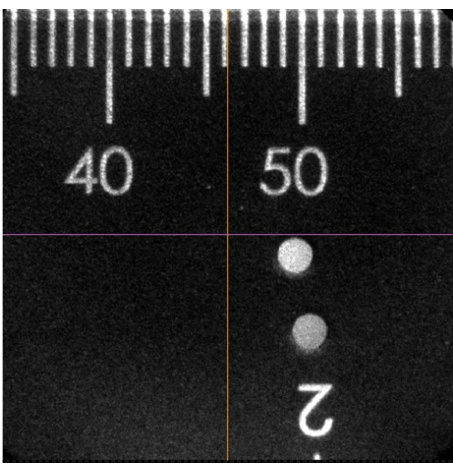
Figure 2. The image of a Thorlabs steel ruler on the ICCD active area by the lens system of the Na imager. One tick mark represents 1 mm.